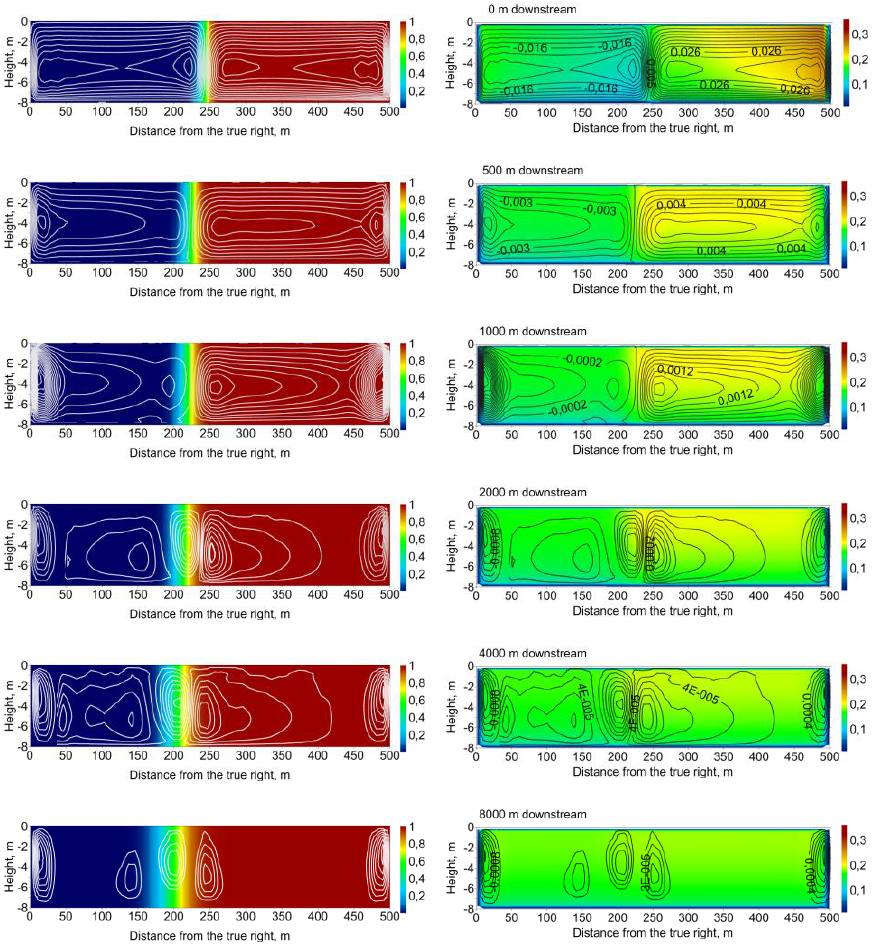
Figure 5. Predictions of concentration ( left ) and primary velocity ( right , m · s − 1 ) with the stream function for Q r = 0.62 and the R simulation geometry. Contours of flux are shown (units of m 2 · s − 1 ) as calculated by the stream function. Plots are viewed looking upstream, such that the Kama is on the left of each plot (i.e., the true right) and the Vishera on the right of each plot (i.e., true left). The contour values are only shown on the primary velocity plots.